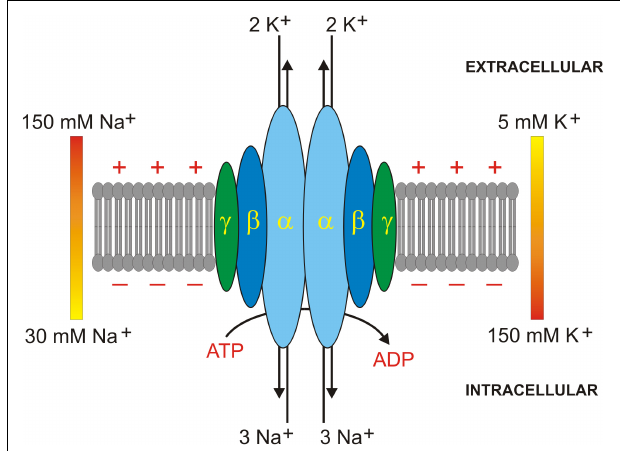
FIGURE 2 | Na + /K + ATPase subunit assembly in plasma membrane. Na + /K + ATPase is a heterodimer of 1 alpha ( α , light blue) and 1 beta ( β , dark blue) subunit. A regulatory gamma ( γ , dark green) subunit sometimes oligomerizes in some tissues. 3 Na + and 2 K + ions are translocated across the plasma membrane by hydrolysis of 1 ATP to 1 ADP molecule. Extracellular to intracellular ionic gradients for Na + (150–30 mM) and K + (5–150 mM) are shown. Positive and negative signs depict membrane potential created by Na + and K + ion